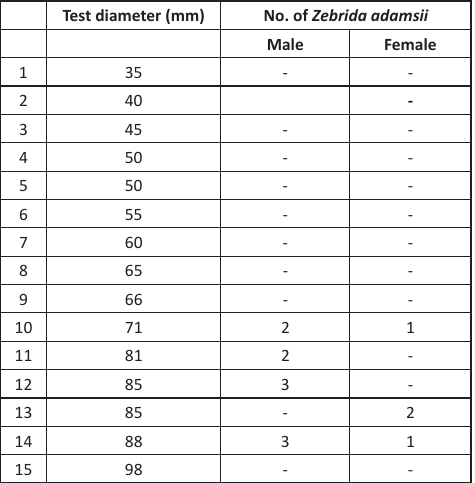
Table 2. Seaurchin T. pileolus Test diameter and the number of Zebrida adamsii